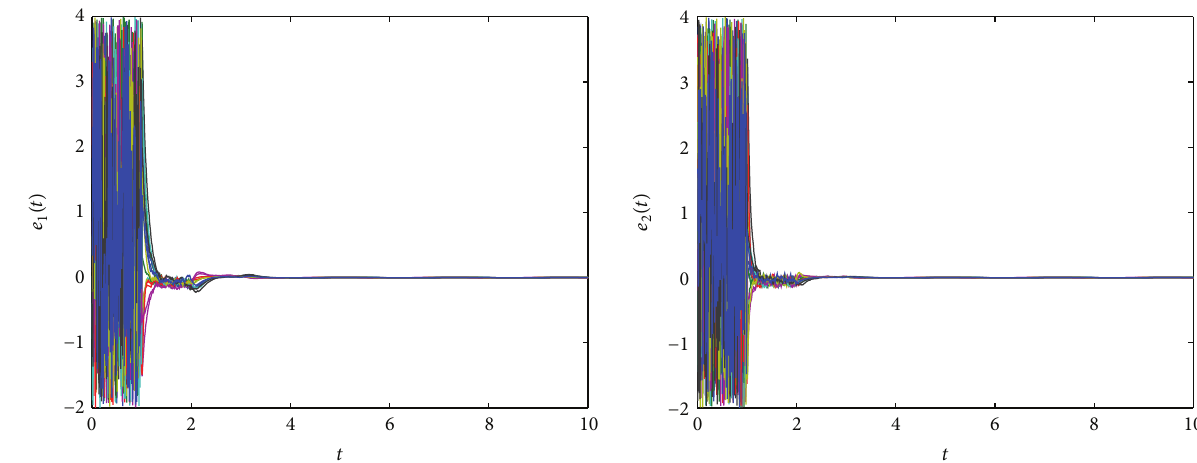
Figure 4: Time responses of state variables 𝑒 1 and 𝑒 2 of switched error-state